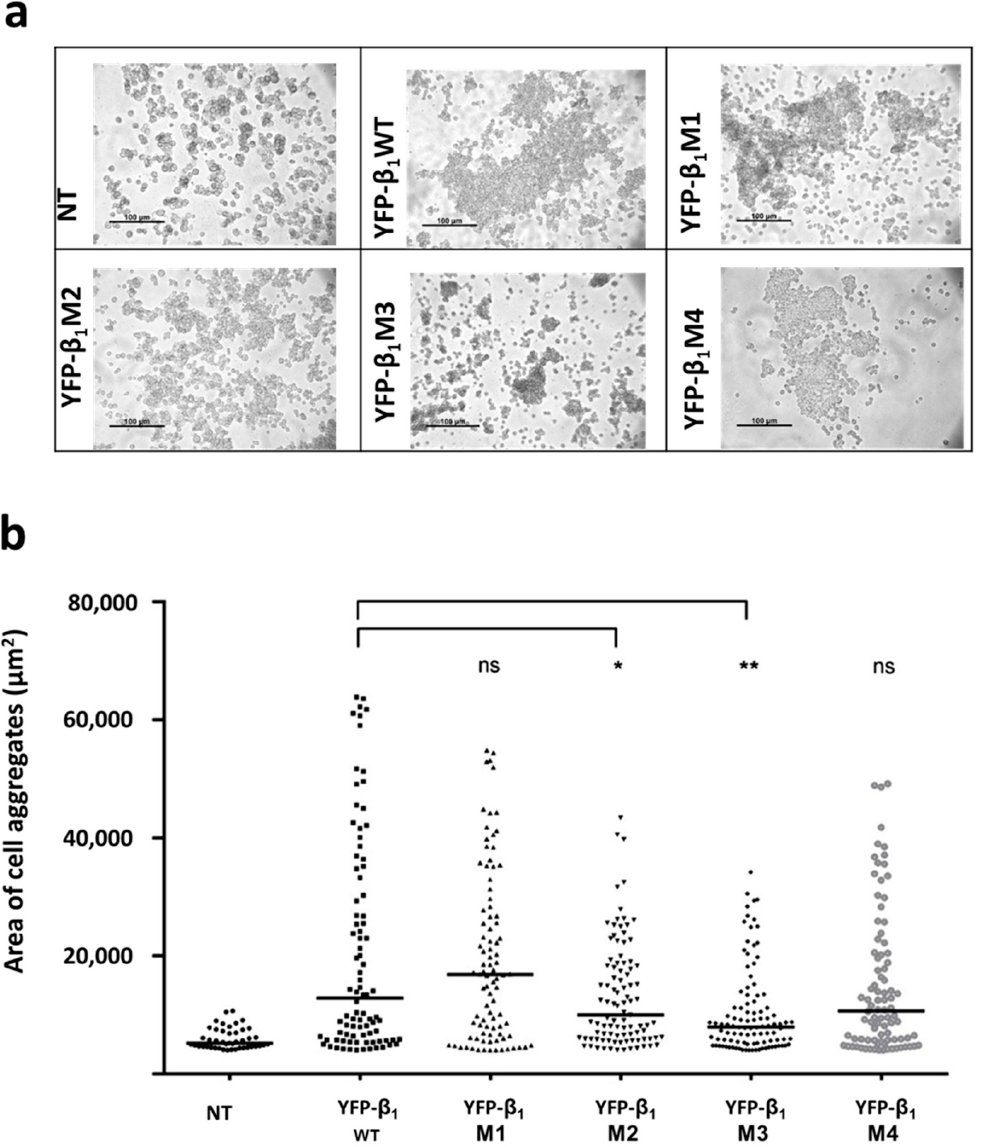
Figure 5. Fibroblasts expressing mutants YFP- β 1 M2 and M3 show lower adhesiveness. ( a ) Representative snapshots of cells submitted to a Dispase assay. ( b ) Distribution Graph of fragments larger than 5000 µm 2 . Horizontal bars represent median values, (n = 4) *, significant difference p < 0.05; **, significant difference p < 0.01 and ns = non-significant, non-parametric Mann-Whitney’s test.